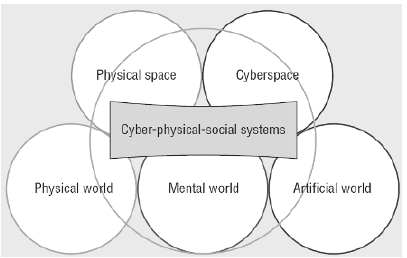
Figure 10. From Popper’s three worlds to cyber-physical social systems (see [57]).